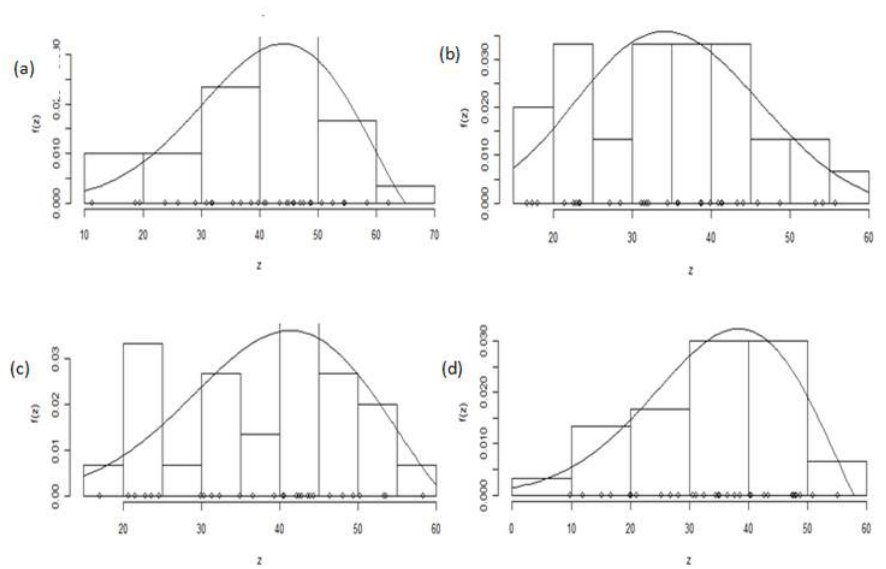
Figure 14. Probability density function distribution (pdf) of (a) control period compared with the future period for (b) 2020s (c) 2050s, (d) 2080s of annual extremes events for B2 scenario.